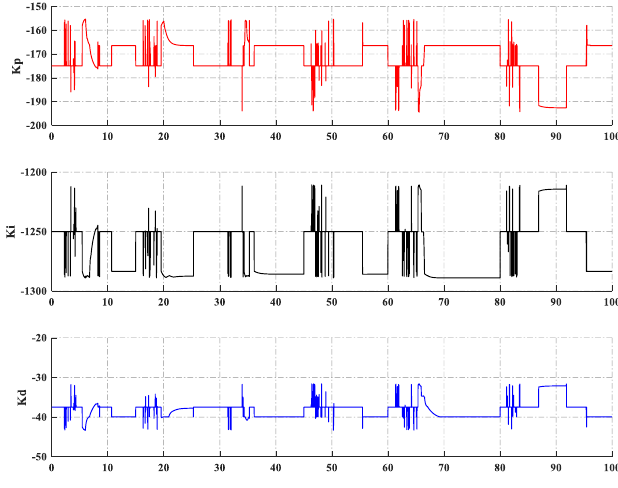
Figure 17. Tuning parameters of K p , K i , and K d .